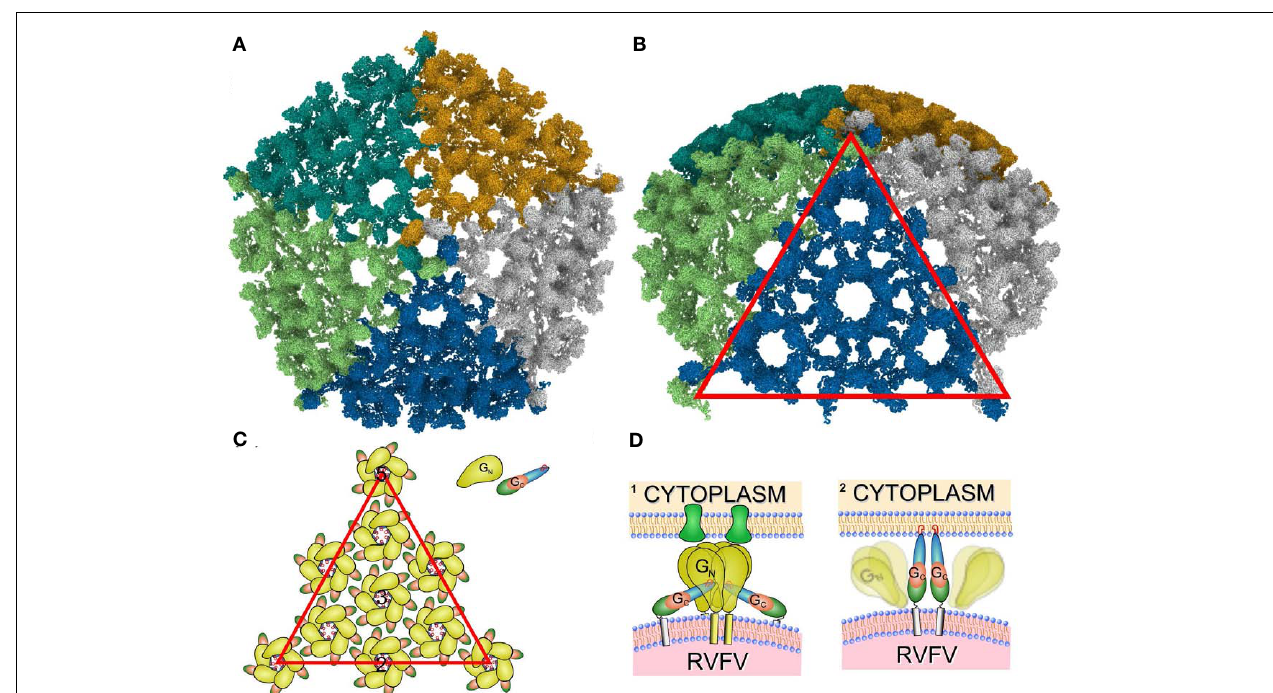
(domain II), and green (domain III).The fusion peptides are indicated as red circles, and are pointing to the capsomer center. (D) Hypothetical model of the RVFV – host cell interaction.The RVFV glycoproteins Gn and Gc are represented according to our model and show similarities to the alphavirus E1 and E2 proteins. (1) Gn is depicted as the receptor binding protein and binds to the host cell receptor (green). (2) After receptor binding the uptake of the RVFV particle is initiated and an acidification step of the endocytic vesicle triggers the dissociation of Gn and Gc.This results in the formation of potentially Gc trimers (in accordance with current models for class II fusion proteins) and insertion of the fusion peptides into the host cell